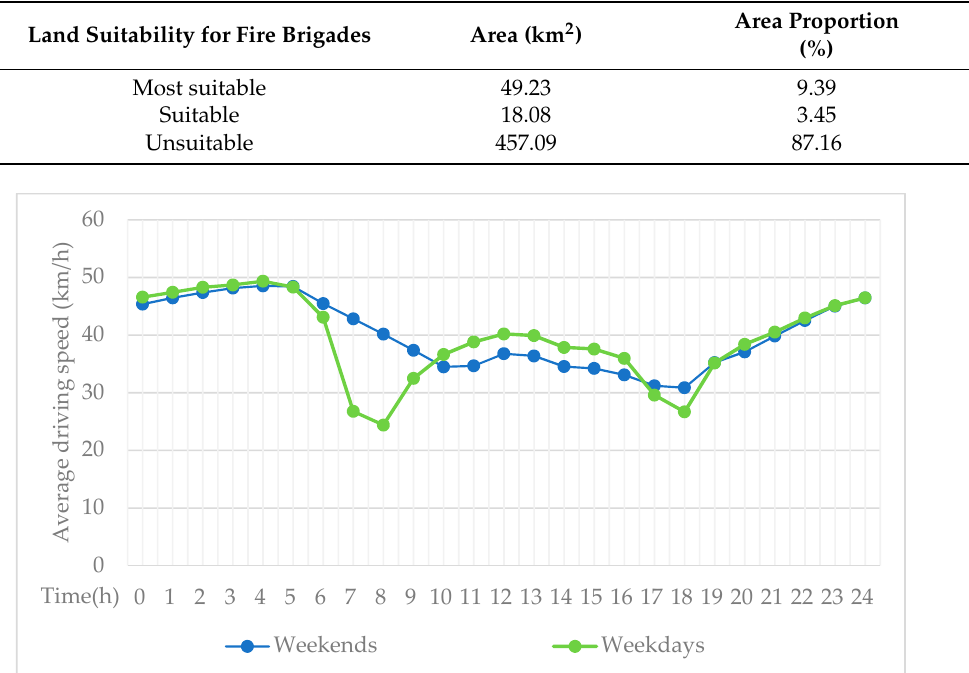
Figure 11. Average speeds on Wuhan road network. The MCLP method was used to analyze the coverage of the 47 existing fire brigades and set the response time to five minutes (see Figure 12). From the analysis of the overall coverage of urban buildings, of the 9981 buildings, existing fire brigades cover 9310 build- ings, which gives a coverage rate of 93.28%. An analysis of the spatial distribution of un- covered buildings indicates that fire brigade rescue services are lacking in the north, south, southwest, and east areas. An analysis of the coverage of fire-risk areas indicates that the existing fire brigades cover 100% of the top 30% of fire-risk areas, and 98.3% of the top 50% of fire-risk areas, as shown in Figure 13. This spatial analysis shows that the existing fire brigades are evenly distributed but that there is a lack of fire brigades in the